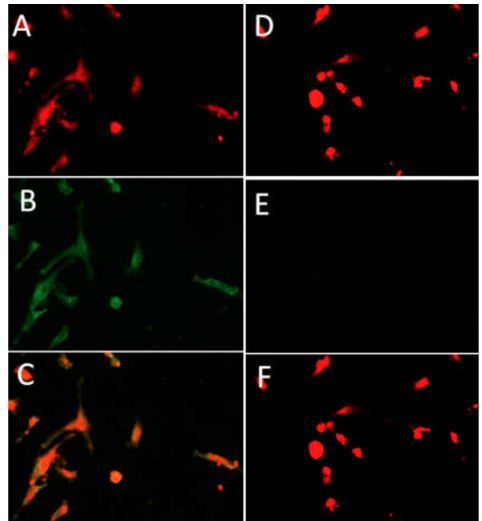
Figure 2. Granulosa cells (GCs) identification by immunofluorescence. PI-positive stained nuclei ( A , D ). FSHR-positive stained cells ( B ). ( E ) Negative control. ( C ) Image merging of ( A ) and ( B ); ( F ) Image merging of ( D ) and ( E ). A 50X magnification was